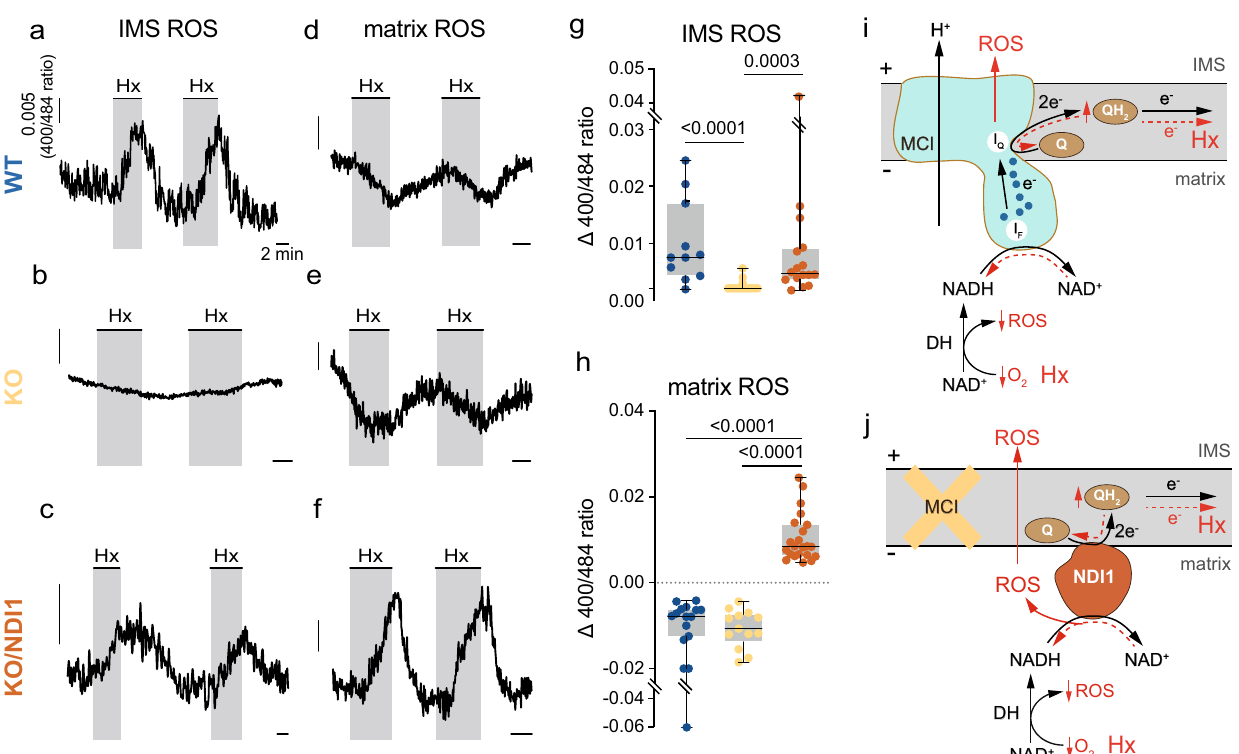
Fig. 5 | Mitochondrial ROS compartmentalization and hypoxia signaling in complex I-de fi cient and NDI1-expressing glomus cells. a – f Representative micro fl uorimetric recordings of changes in reactive oxygen species (ROS) at the mitochondrial intermembrane space (IMS ROS, a , b , c ) and at the mitochondrial matrix (matrix ROS, d , e , f ) induced by hypoxia (Hx, O 2 tension ~15mmHg) in glomus cells in CB slices from WT ( a , d ), KO ( b , e ) and KO/NDI1 ( c , f ) mice. Cali- bration bars as indicated in ( a ). g , h Boxplots representing hypoxia-induced increases (increase in 400/484 ratio) in IMS ROS ( g ) and matrix ROS ( h ) in glomus cells from WT mice (blue dots, IMS ROS, n =11/6 cells/mice; matrix ROS, n =15/8 cells/mice),KOmice(yellowdots,IMSROS, n =15/3cells/mice;matrixROS, n =13/4 cells/mice), KO/NDI1 mice (brown dots, IMS ROS, n =16/7 cells/mice; matrix ROS, n =22/10 cells/mice). All individual data points are superimposed. The boxplots indicate median (middleline), 25th, 75th percentile (box), and largest and smallest valuesrange (whiskers). Indicated P valueswerecalculatedwith Kruskal-Wallistest